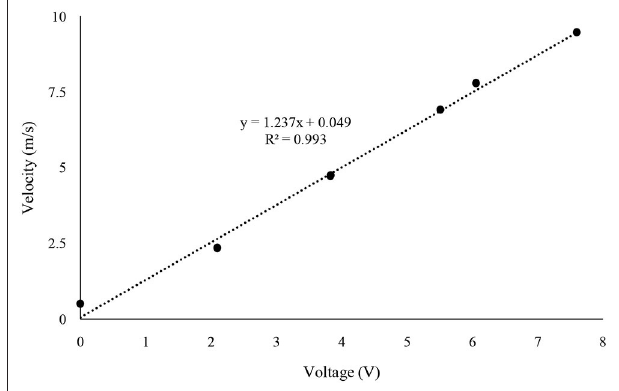
FIGURE 2 | Calibration of air wind speed sensor.